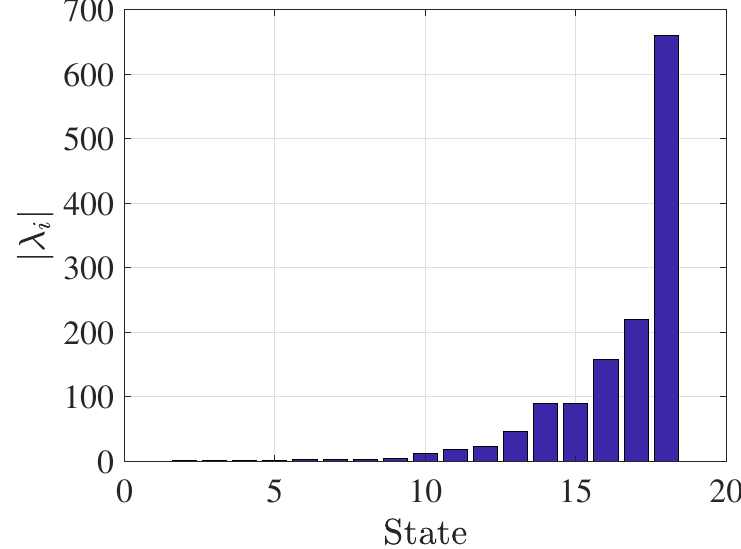
Figure 2. Magnitude of the eigenvalues of the PEMFC-FPS (fuel processor system) augmented